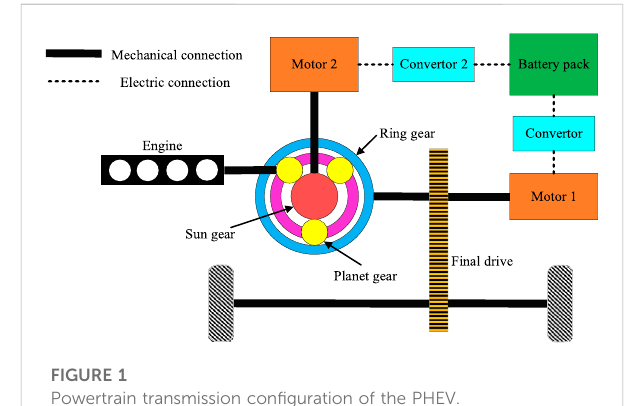
FIGURE 1 Powertrain transmission con fi guration of the